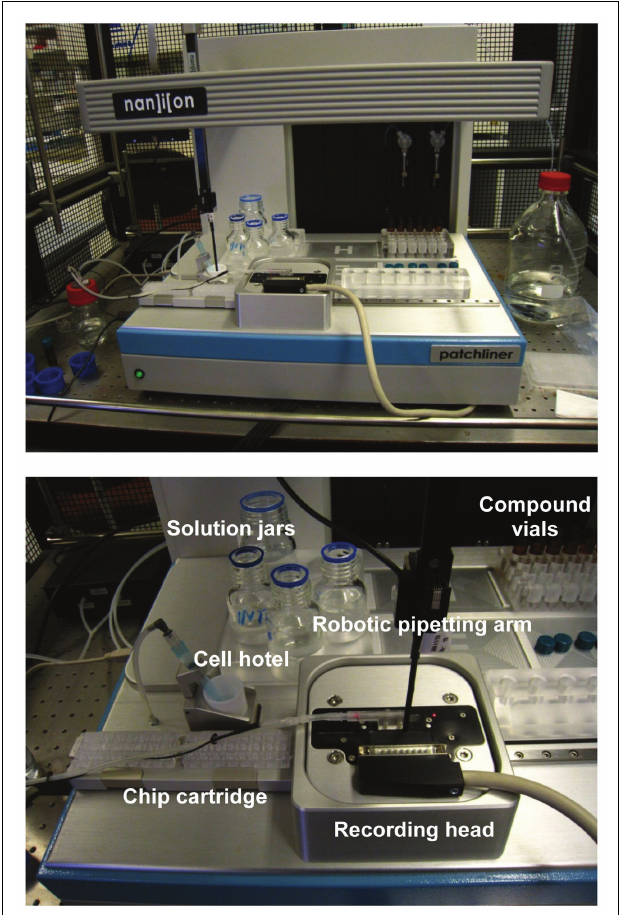
FIGURE 1 |The Patchliner ® is shown at the top panel and a closer view of the working area is presented